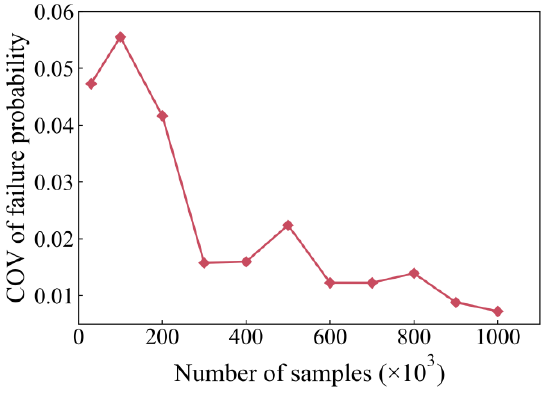
Figure 10. Effect of sample size on COV of failure probability. Table 5. Stochastic variables used for Monte Carlo simulation.